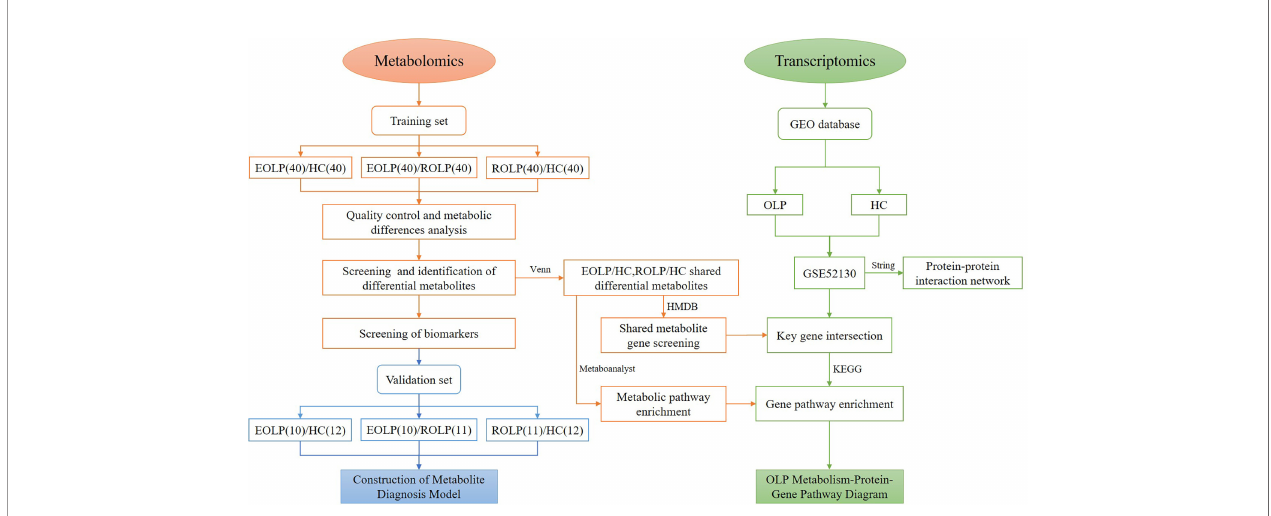
FIGURE 1 | Research fl ow